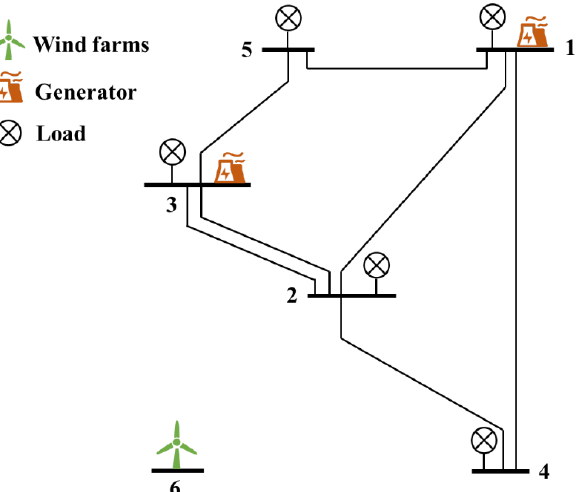
Figure 3. Flow diagram for the wind power generation based on LHS.